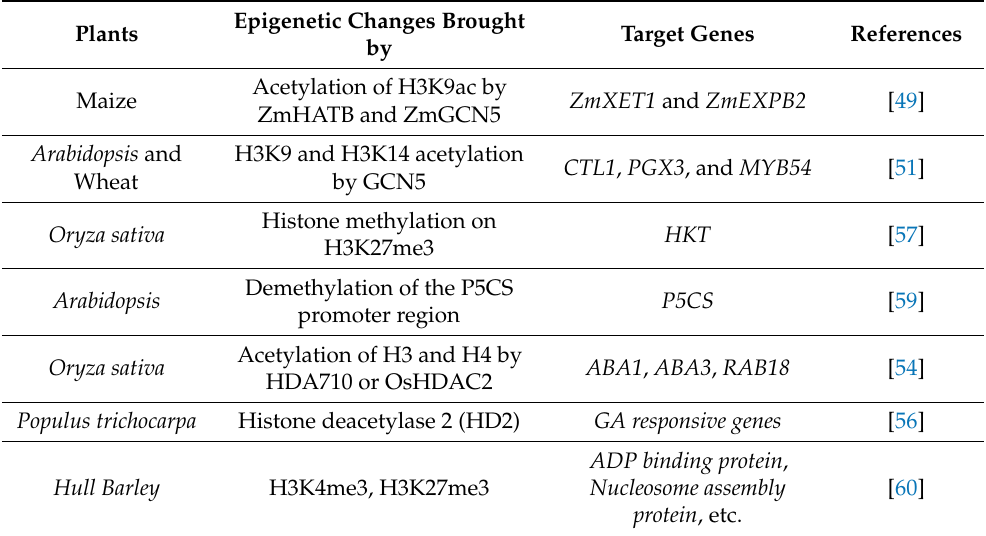
Table 2. Modifications of histone proteins bring in epigenetic changes under salt stress. A summary of recently reported histone modifications and their target genes are enlisted